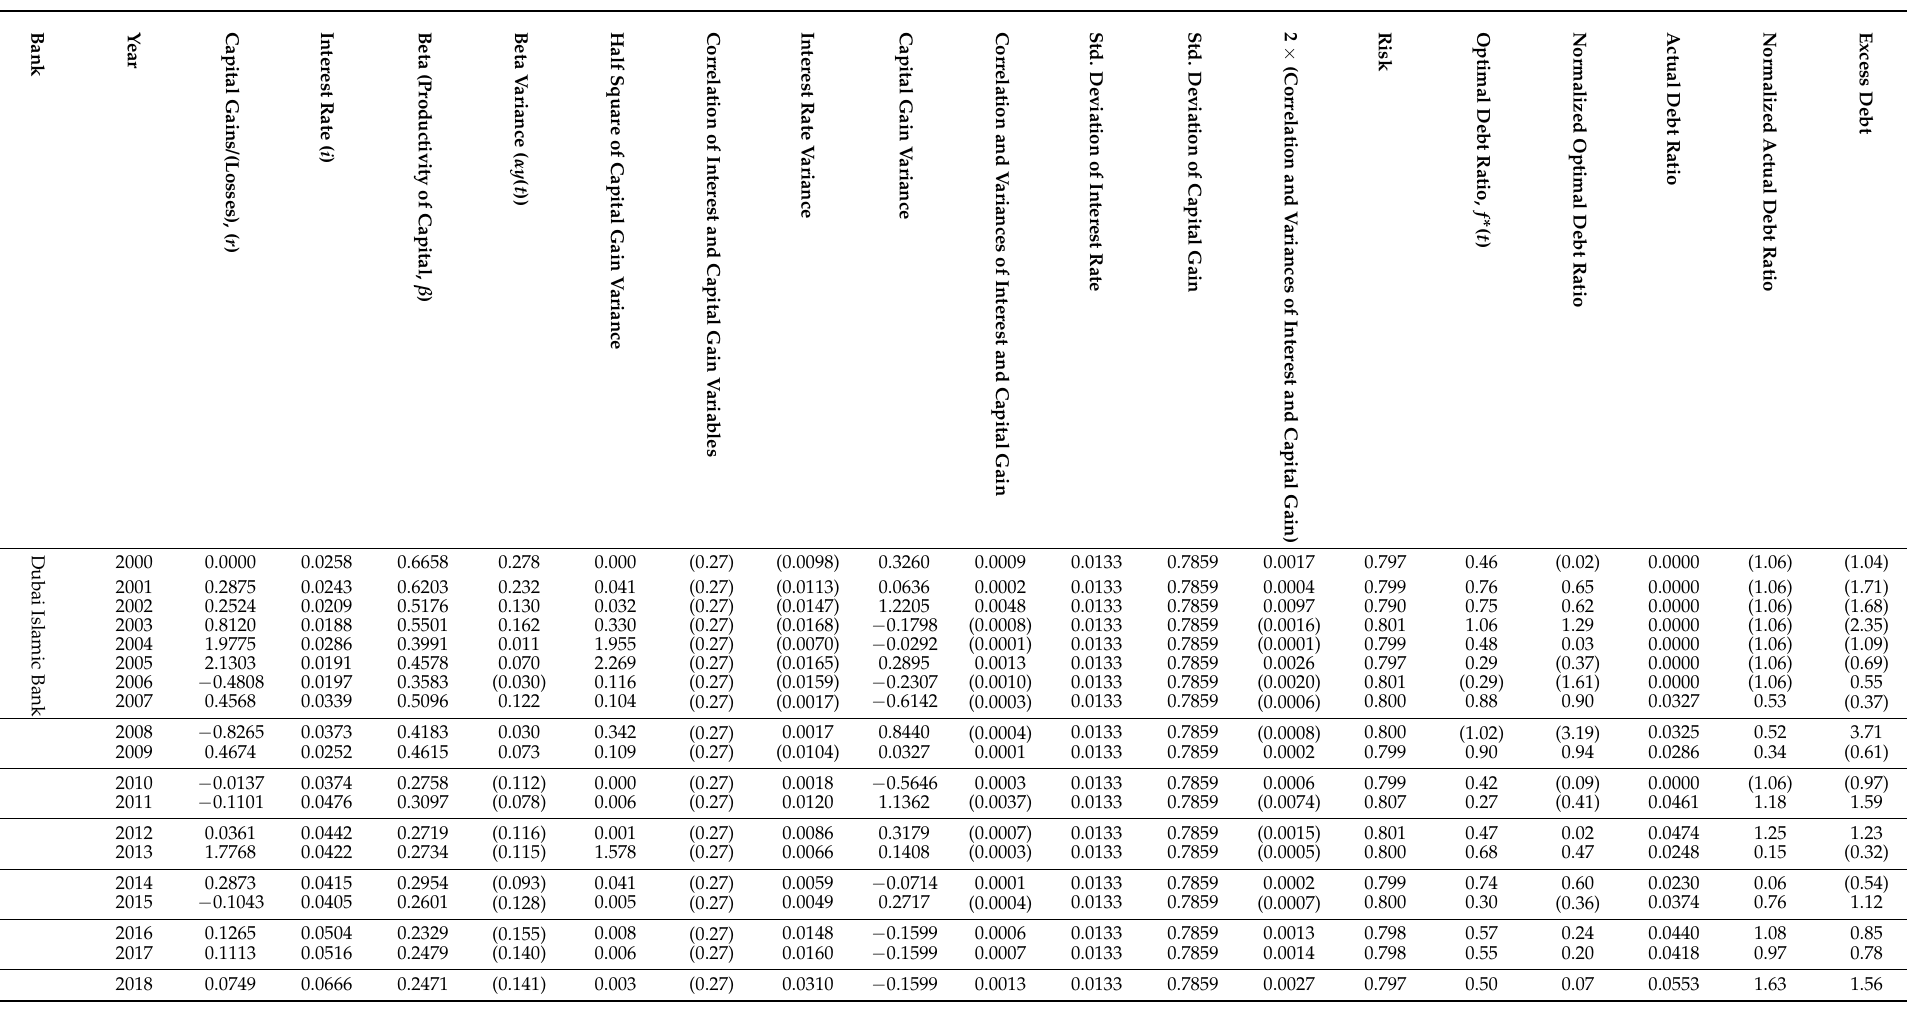
Table A3. Calculations of Optimal and Excess Debt: Dubai Islamic